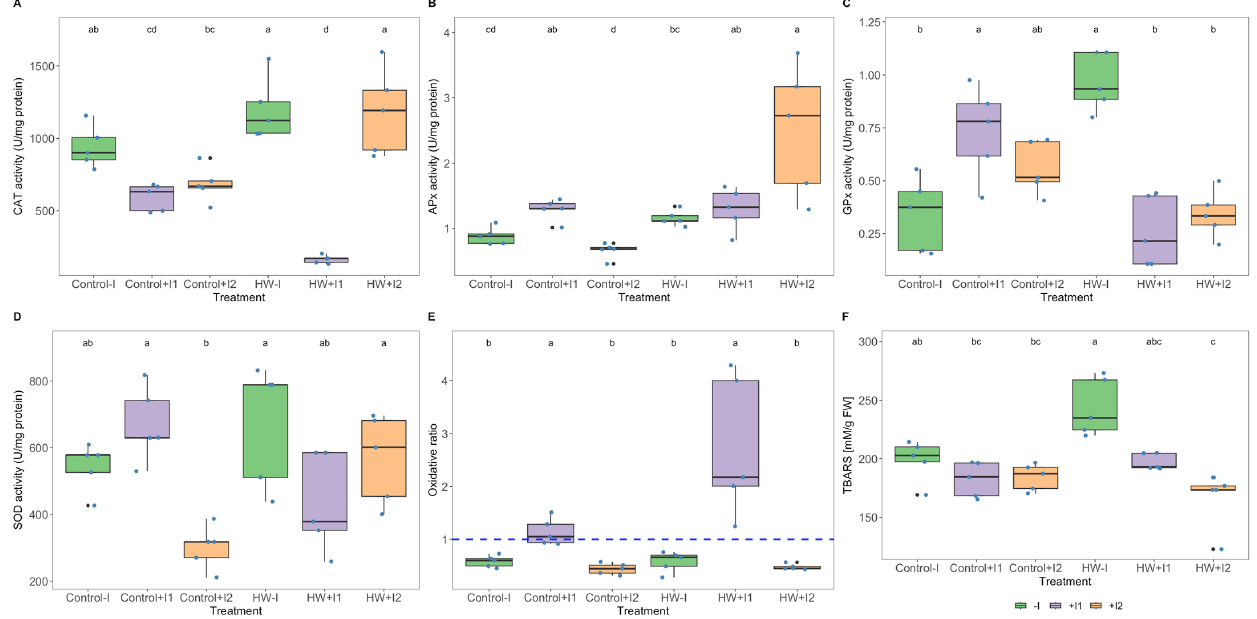
Figure 8. Oxidative stress biomarkers, ( A ) catalase (CAT), ( B ) ascorbate peroxidase (APx), ( C ) guaiacol peroxidase (GPx), ( D ) superoxide dismutase (SOD) activities (U mg −1 protein), ( E ) oxidative ratio and ( F ) thiobarbituric acid reactive substances (TBARS; µM MDA g −1 FW) in non-inoculated ( − I) and marine PGPR consortia 1- and 2-inoculated (+I) Vitis vinifera leaves, under normal (control) thermal regimes and exposed to the heatwave (HW) (average ± standard deviation, N = 5, letter denote significant differences at p < 0.05).